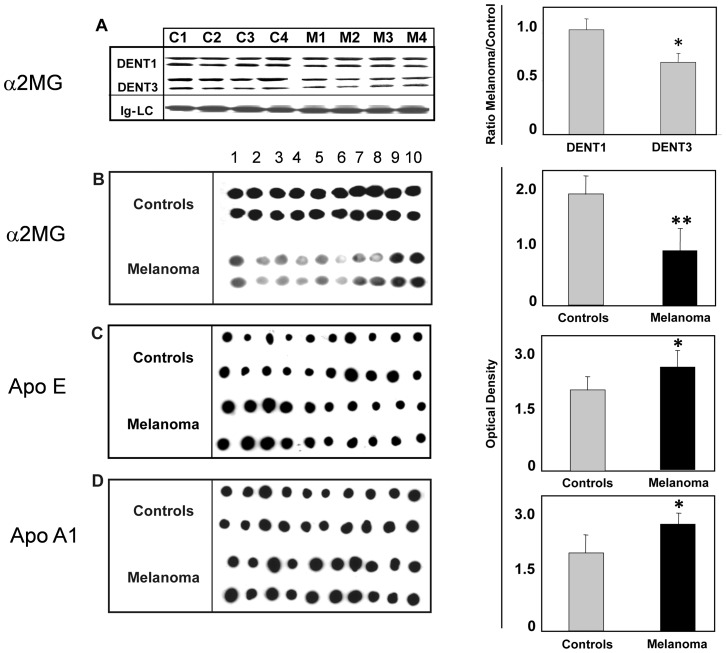
Immunological validation of α2MB, Apo E and Apo A1 as potential diagnostic biomarkers.A: Representative WB with anti-α2MB on human sera from 4 healthy (C) and 4 melanoma (M) affected individuals. The sera were pre-treated with the TRIDENT protocol, fractionated on gradient manually poured gels and submitted to electro-blotting (see Methods). In the Figure only the DENT1 and DENT3 protocols are shown. Each lane was loaded with 120 µg of serum proteins. Densitometric analysis (right panel), reports the ratio Melanoma/Control expression for the α2MG band, revealed as a doublet under this pre-treatment protocol (* = p<0.032). The same amount of protein was loaded per lane, as confirmed by comparing immunoglobulin light chain (Ig-LC) stained by Coomassie blue. B: Dot blot with anti-human α2MG on human sera from 10 healthy (Controls) and 10 melanoma affected individuals. The sera diluted 1∶5 with PBS were loaded in duplicate on nitrocellulose membrane (50 µg of total proteins per spot, equal amount of loaded proteins checked by Bradford assay and Ponceau Red) and submitted to primary anti-human α2MG, then HRP-conjugated secondary antibodies incubation followed by ECL detection (** = p<0.001). Densitometric analysis (right panel) reports the evaluation of α2MB expression in controls and melanoma sera. Data are reported as means ± SD. C and D: Dot blot with anti-human Apo E and Apo A1, respectively, carried out as above described (* = p<0.04).